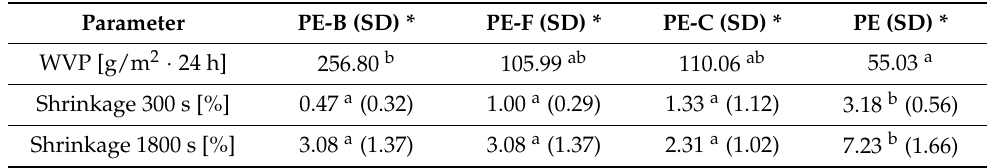
Table 3. Water vapor permeability (WVP) and shrinkage PE–pomace based